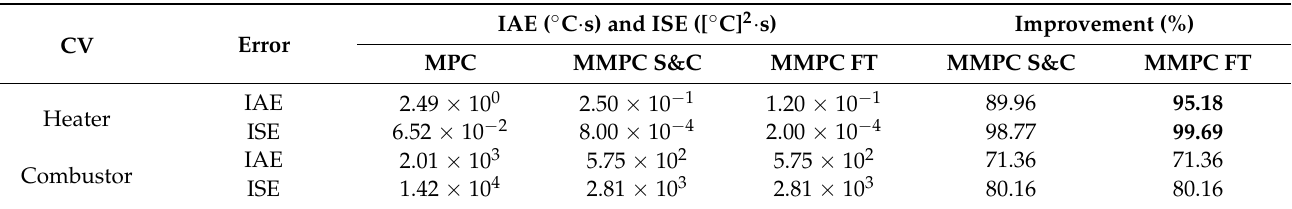
Table 18. MMPC performance (IAE) and performance improvement in the steam reformer unit.